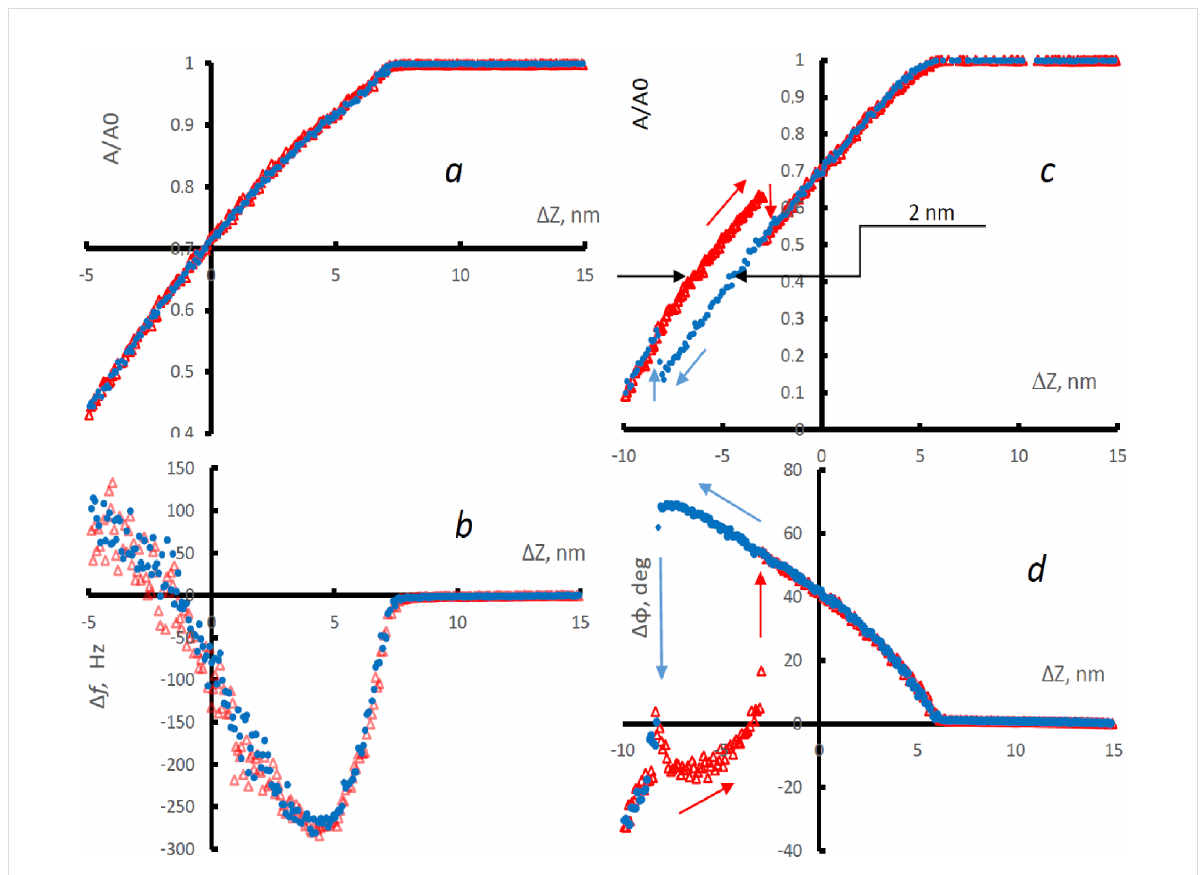
Figure 1: Approach (blue dots) and retraction (red triangles) curves. Change in amplitude (a) and frequency (b) during auto-tuning of the resonant fre- quency of the probe. Change in amplitude (c) and phase (d) at a fixed oscillation frequency of the probe.